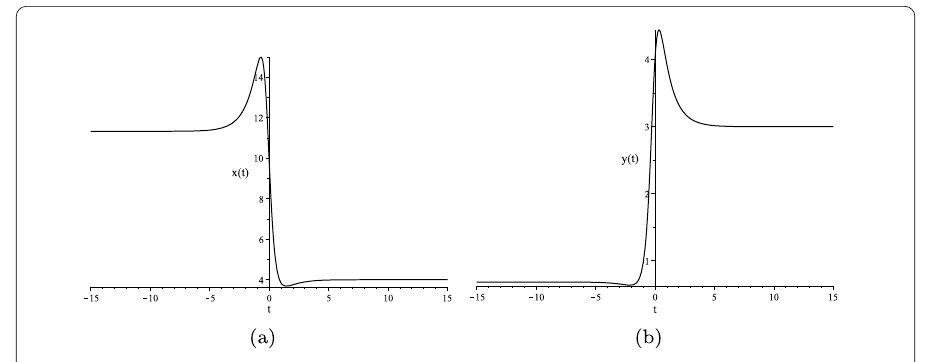
Figure 2 Dark/bright solitary solutions to (40)–(41) with initial conditions x (0) = 10 and y (0) = 4: ( a ) x ( t ) and ( b ) y ( t